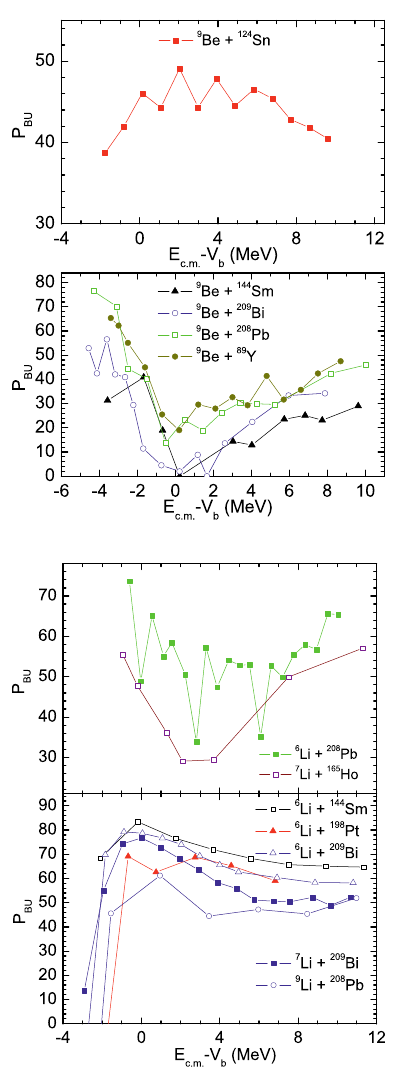
Figure 15. (Color online) The dependence of the extracted breakup probability P BU (in %) vs E c . m . − V b for the indicated reactions with 9 Be-projectiles. Formula (4) was used.